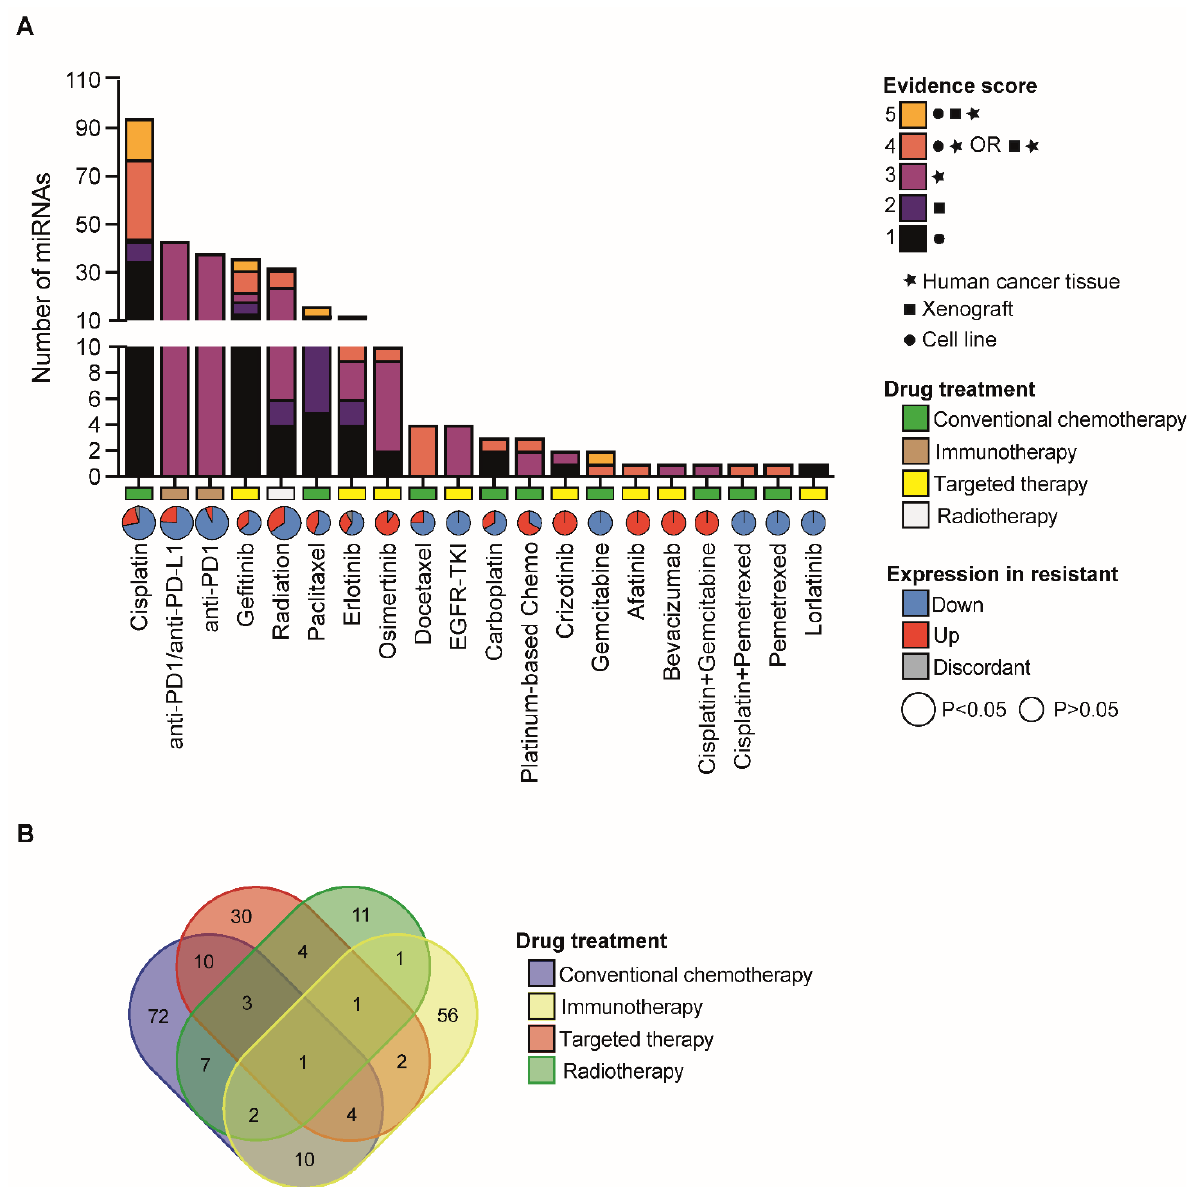
Figure 1. Landscape of miRNAs associated with therapy response in NSCLC. ( A ) Bar chart reporting the number of miRNAs (listed in Table S2) that are associated with therapy response in NSCLC. Different colours indicate relative evidence scores which were assigned to miRNAs based on the type of experiment conducted (i.e., cell lines, xenograft models and/or human cancer tissue). In X-axes, pie charts indicate the fraction of miRNAs whose expression is upregulated (red) or downregulated (blue) in resistant samples vs. sensitive ones. In grey, fraction of miRNAs with a discordant trend of expression regulation (up or down) in independent studies. Pie sizes are proportional to the statistical significance (binomial test) relative to the unbalance in up- or downregulated miRNAs, as per the legend. Type of drug treatment is also indicated in X-axes, as per the legend (see also Supplementary Methods for further details). ( B ) Venn diagram of the overlapping miRNAs associated to the indicated category of drug treatment. The list of miRNAs can be found in Table